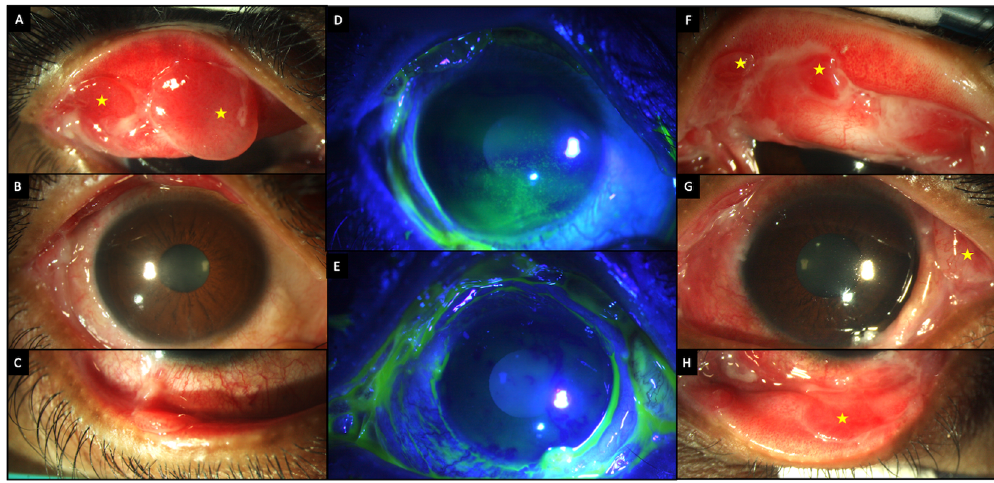
Figure 3. Clinical features at presentation of case 2. (A-C) Slit lamp images of the right eye showing conjunctival congestion,withtwoconjunctivalgranulomassuperiorly(yellow stars)and symblephara inferiorly.(D,E)Fluorescein- stainedimagesoftherightandlefteyesrespectivelyshowingpunctatekeratitisintherighteye.(F-H)Slitlampimages of the left eye showing conjunctival granulomas (yellow stars), with a symblepharon laterally. 19